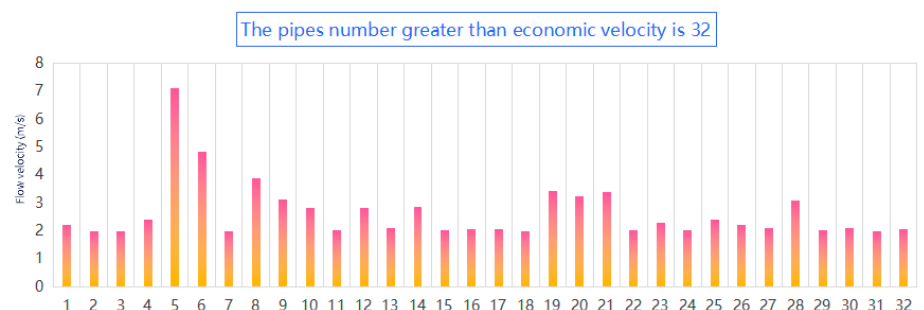
Figure 7. Pipeline flow velocity analysis.